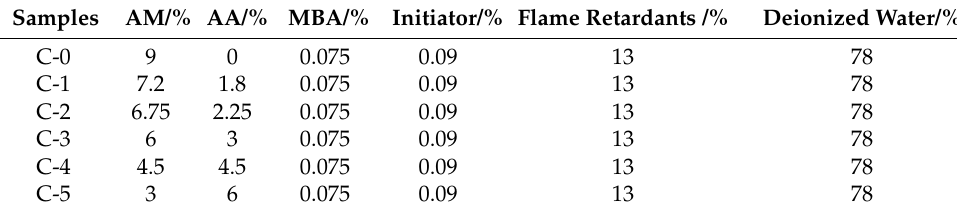
Table 1. Compositions of the transparent flame-retardant hydrogels (mass fraction) %.